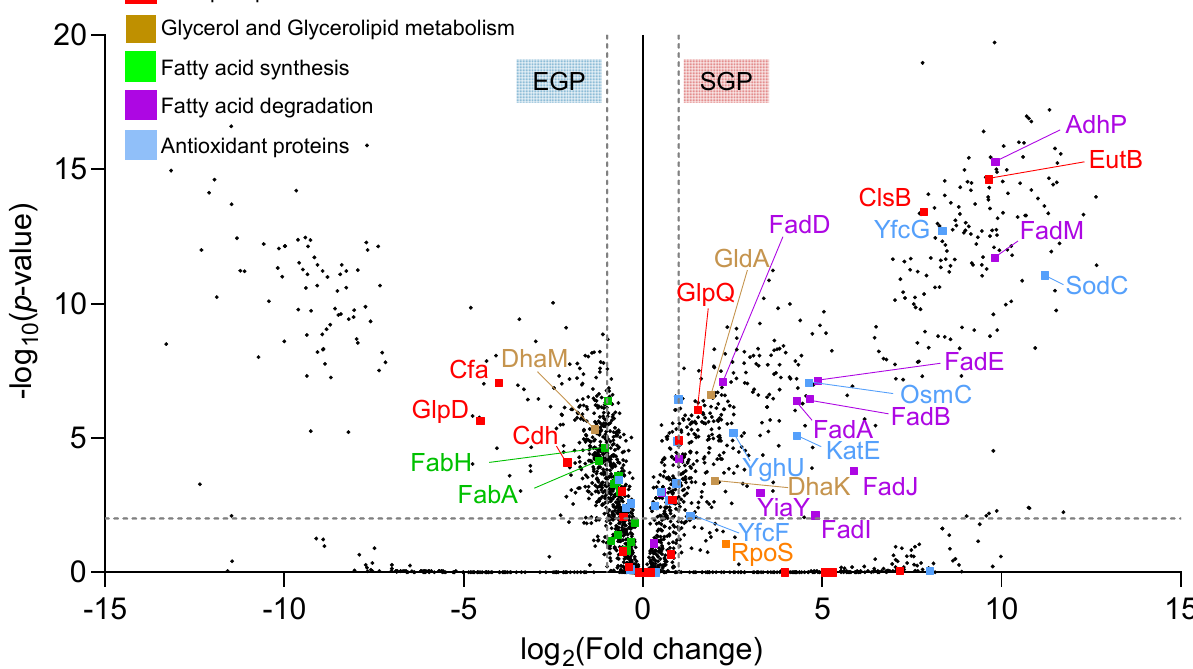
Figure 5. Volcano plot of altered protein abundances from whole-cell extracts of E. coli grown under EGP and SGP conditions, using nLC-DDA-MS/MS proteome analysis. Selected proteins associated with phospholipid metabolism (red), fatty acid synthesis (green), fatty acid degradation (purple), and antioxidant proteins (blue) are highlighted. Dashed lines indicate a twofold change in abundance and p < 0.01. The full names and abbreviations of the enzymes labelled in this figure are shown in Supplementary Table S1.